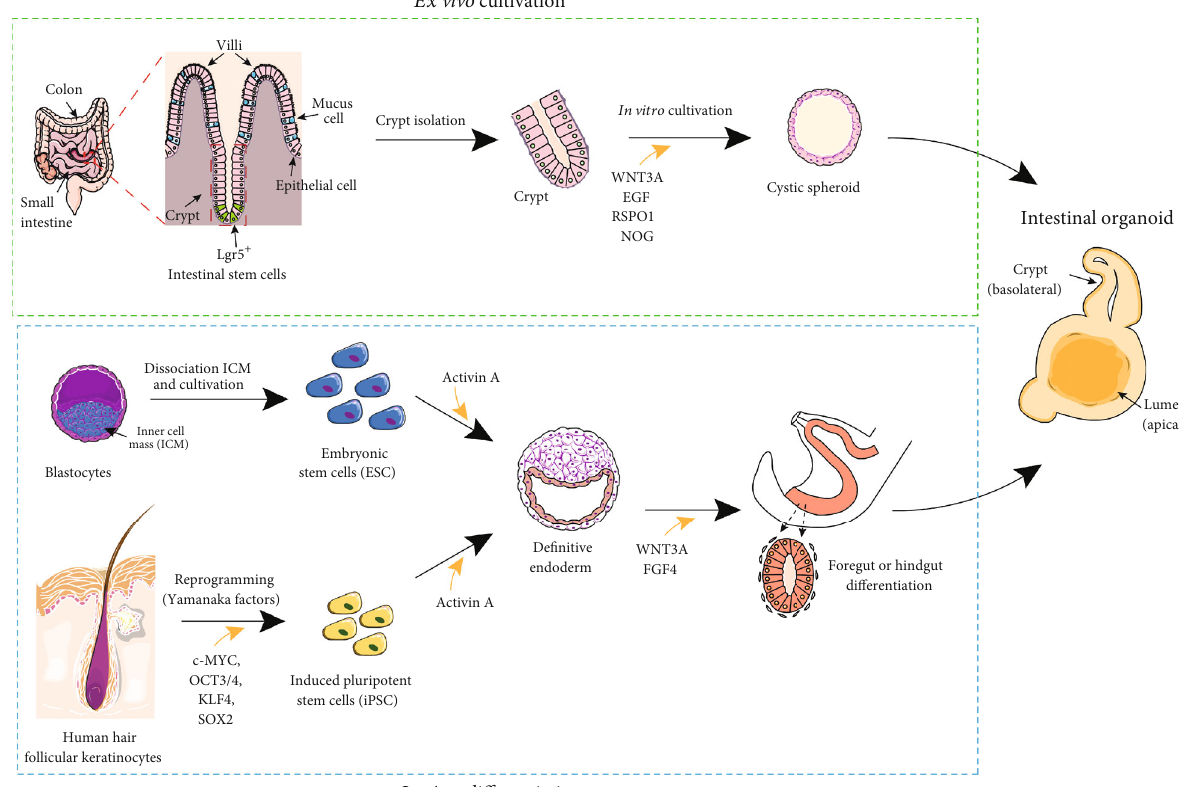
Figure 1: Generation of intestinal organoids from multipotent intestinal stem cells (ISC), embryonic stem cells (ESC), and induced pluripotent stem cells (iPSC). The protocols illustrated above are routinely applied in our